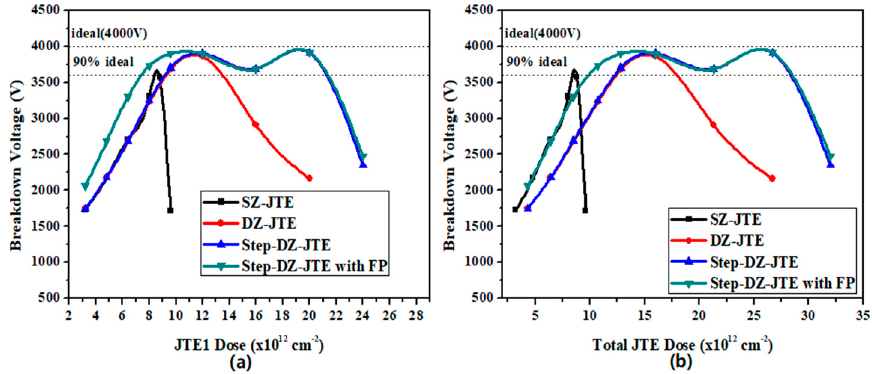
Figure 8. Simulated BV versus ( a ) JTE1 dose and ( b ) total JTE dose for SZ-JTE, DZ-JTE, Step-DZ-JTE without FP, and Step-DZ-JTE with FP.